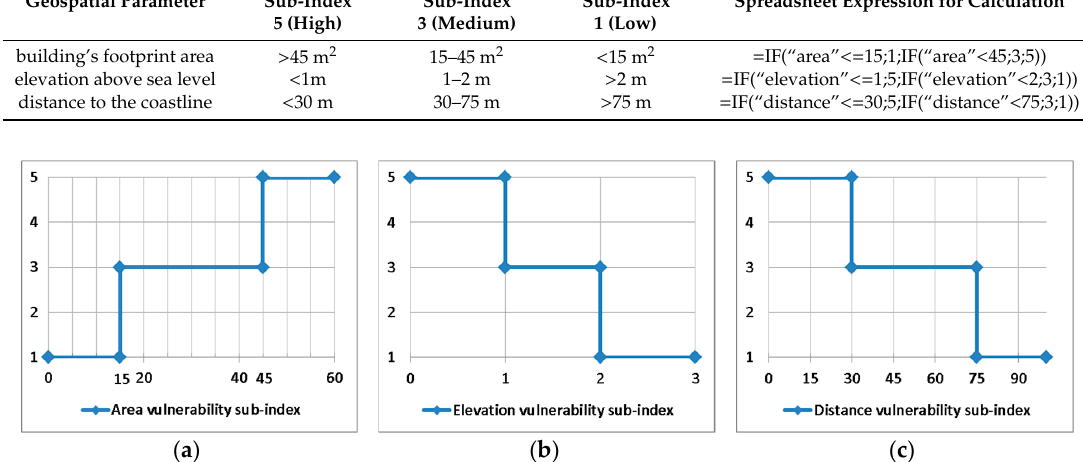
Geospatial Parameter Spreadsheet Expression for Calculation